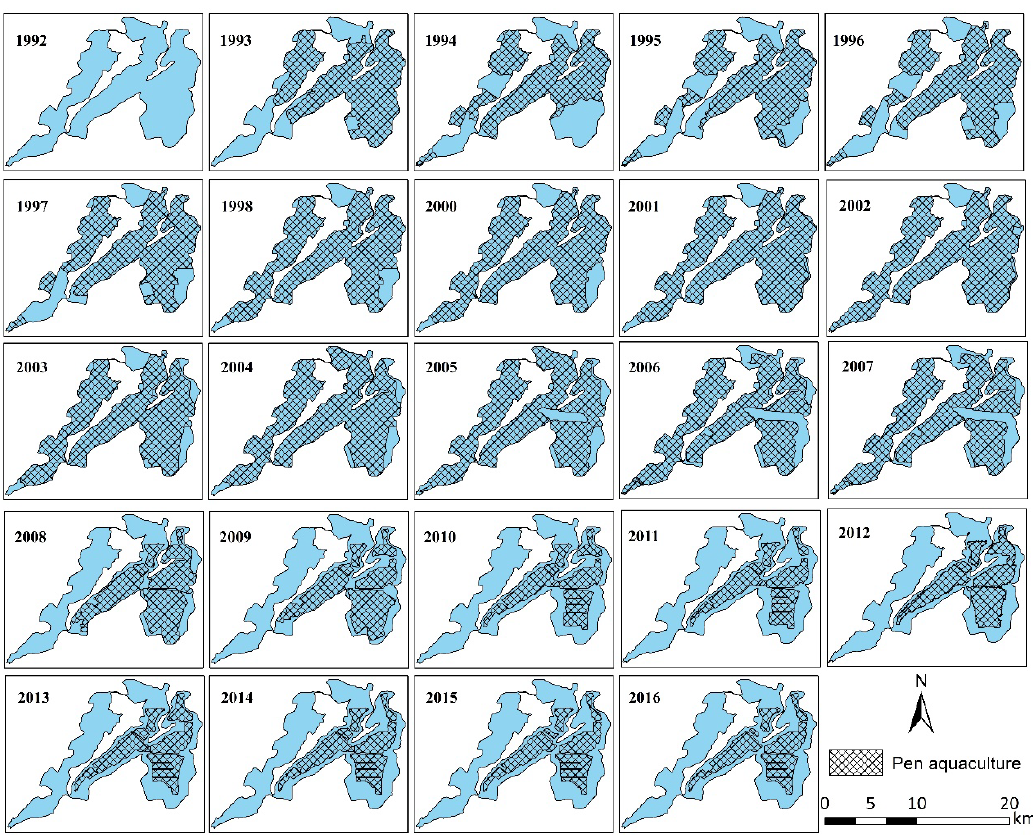
Figure 5. Spatial distribution of pen aquaculture from 1992 to 2016.